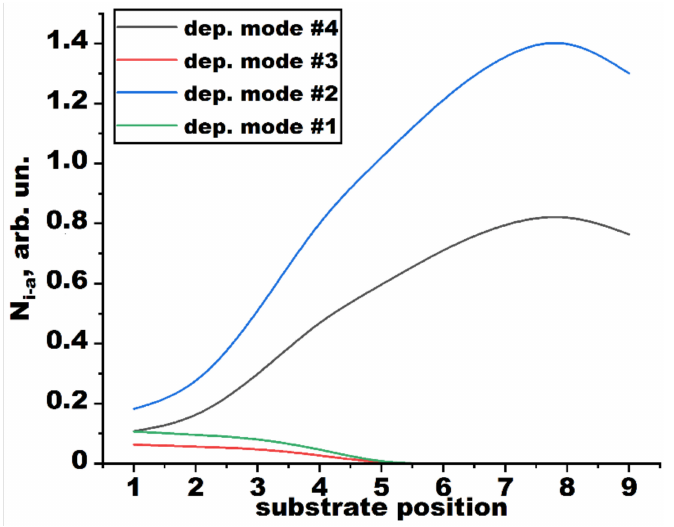
Figure 8. Ion-to-atom ratio vs. substrate positions for different deposition modes of Cr